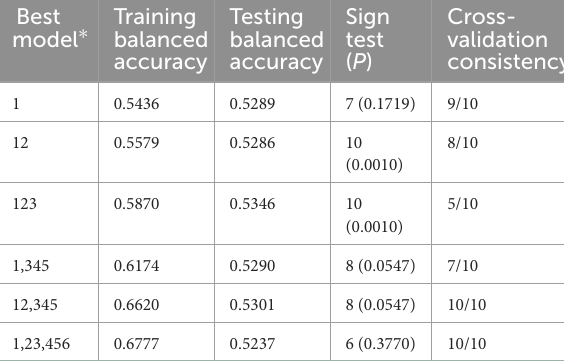
TABLE 4 Comparison of the best models, prediction accuracies, cross-validation consistencies, and P -values identified by GMDR. Best model ∗